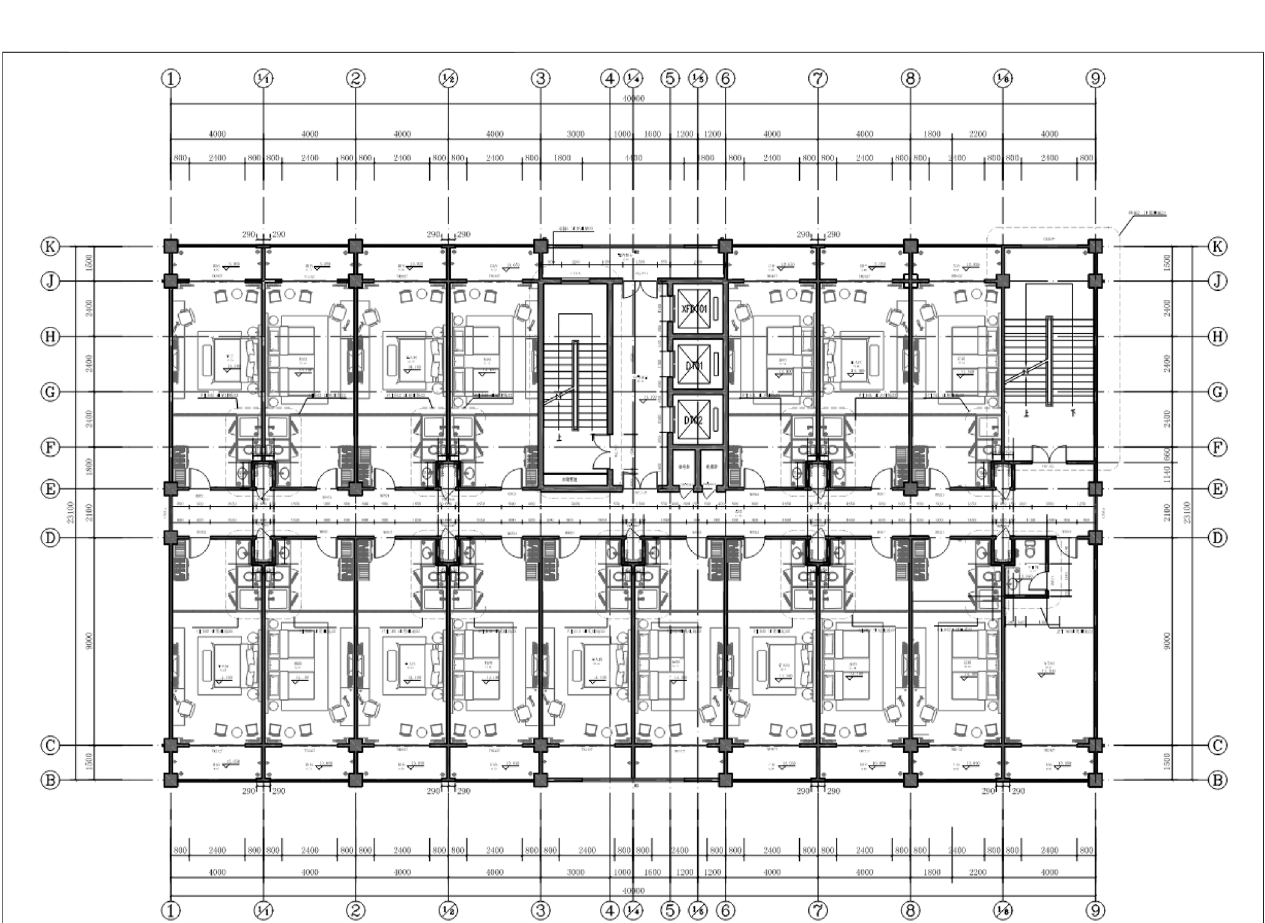
FIGURE 2 | Typical fl oor plan of the hybrid